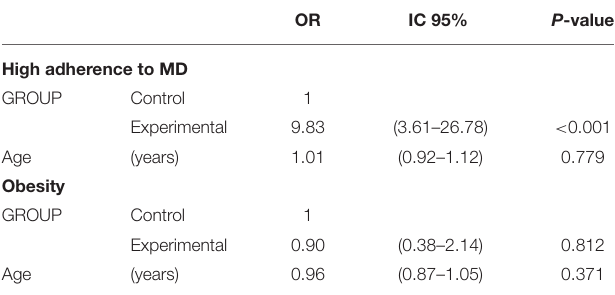
TABLE 1 | Sociodemographic characteristics of the participants. TABLE 2 | GEE models for high adherence to MD and for Obesity.